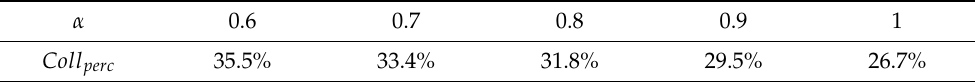
Table 3. Percentage of the total vehicles that are located inside BCZ with the SB